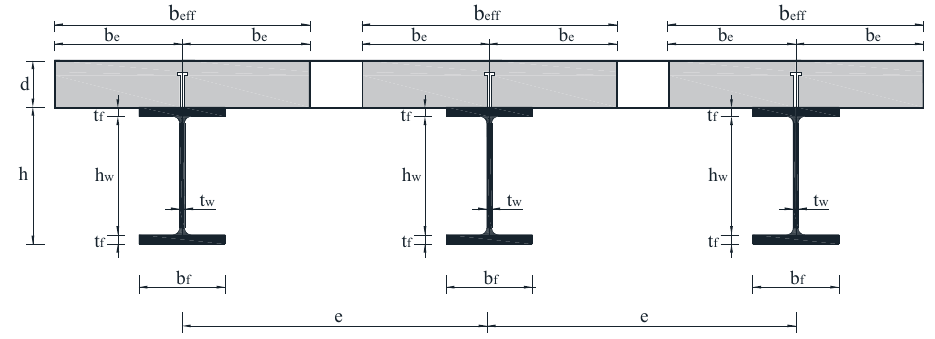
Figure 2. Vertical cross-section of the composite I-beam floor system.